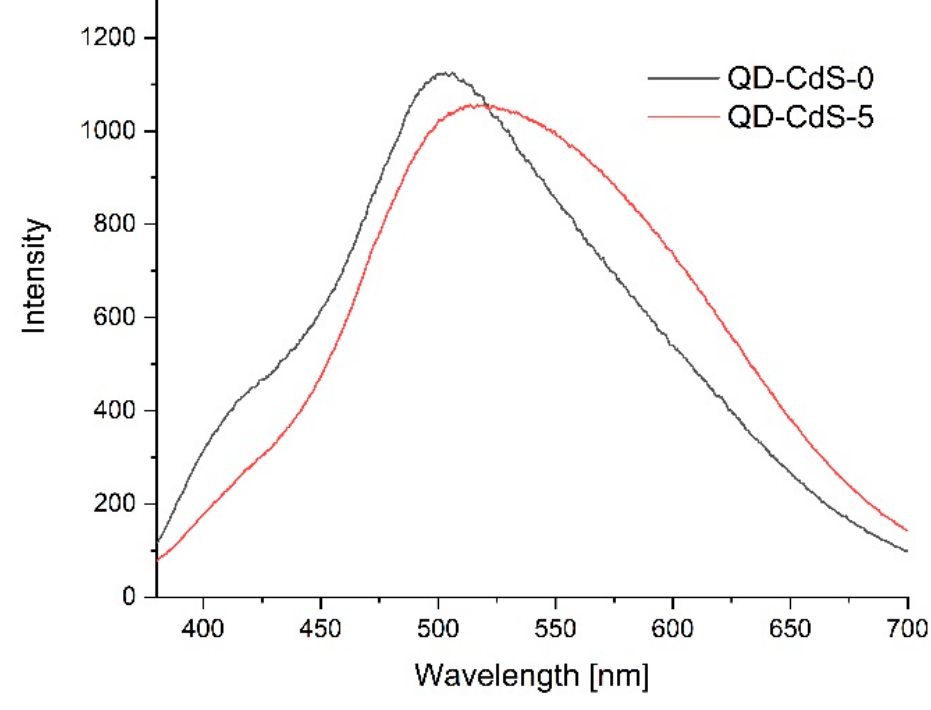
Figure 13. Emission lines of films with CdS quantum dots before poultry meat storage (black line) and after 3 days of storage (red line).